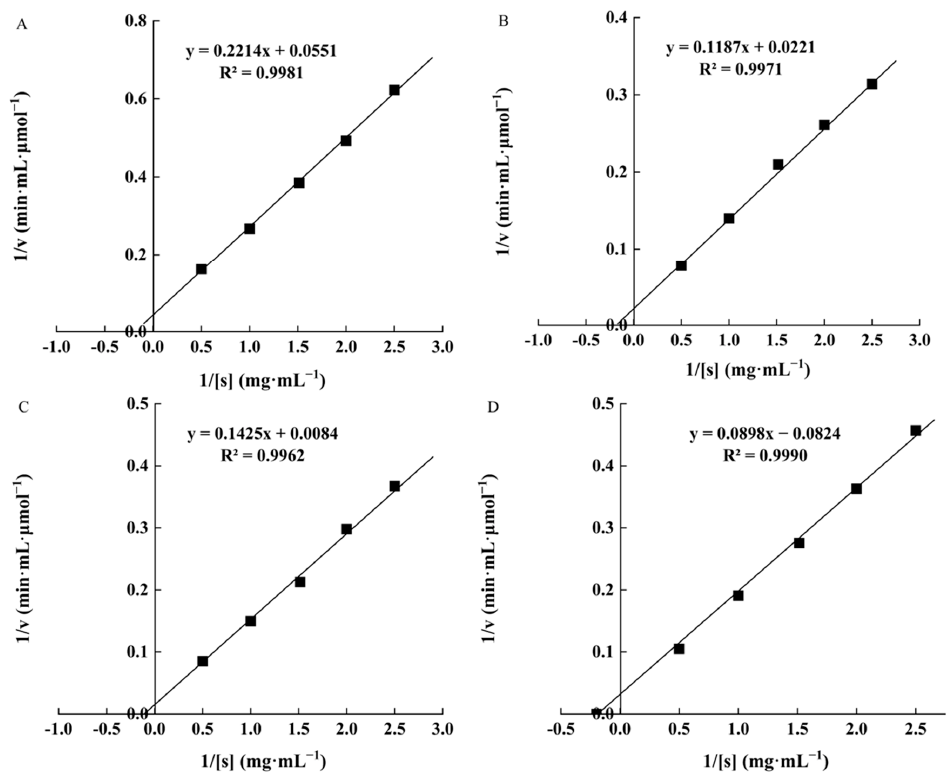
Figure 6. Specificity of W. cibaria F1 mannanase for different substrates guar gum ( A ), konjac power ( B ), locust bean gum ( C ), and pectin ( D ).